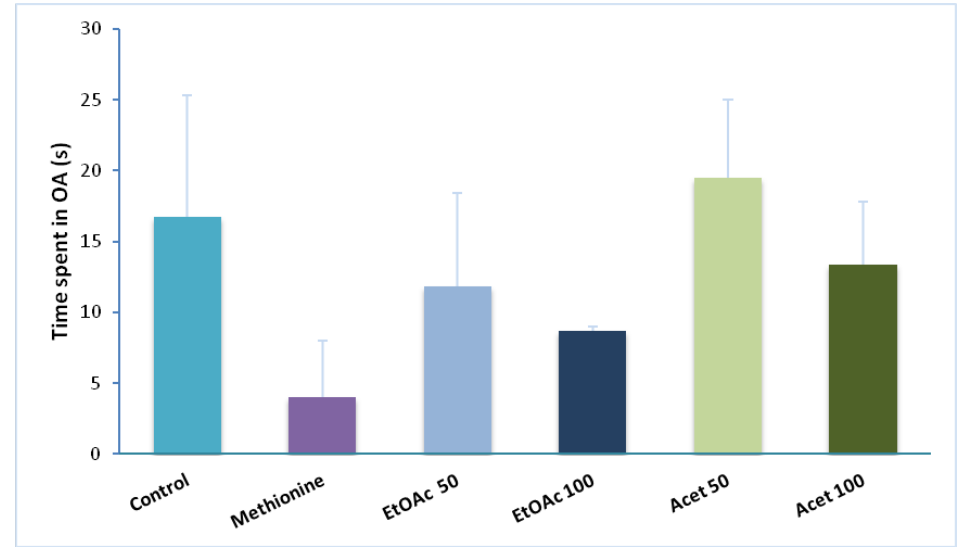
Figure 3. CSP extracts an anxiolytic-like effect represented by the time spent in open arms (OA) by (s) in the elevated plus maze test vs. control and methionine groups. Data represent the mean ± SEM ( n = 4 – 6 per group).